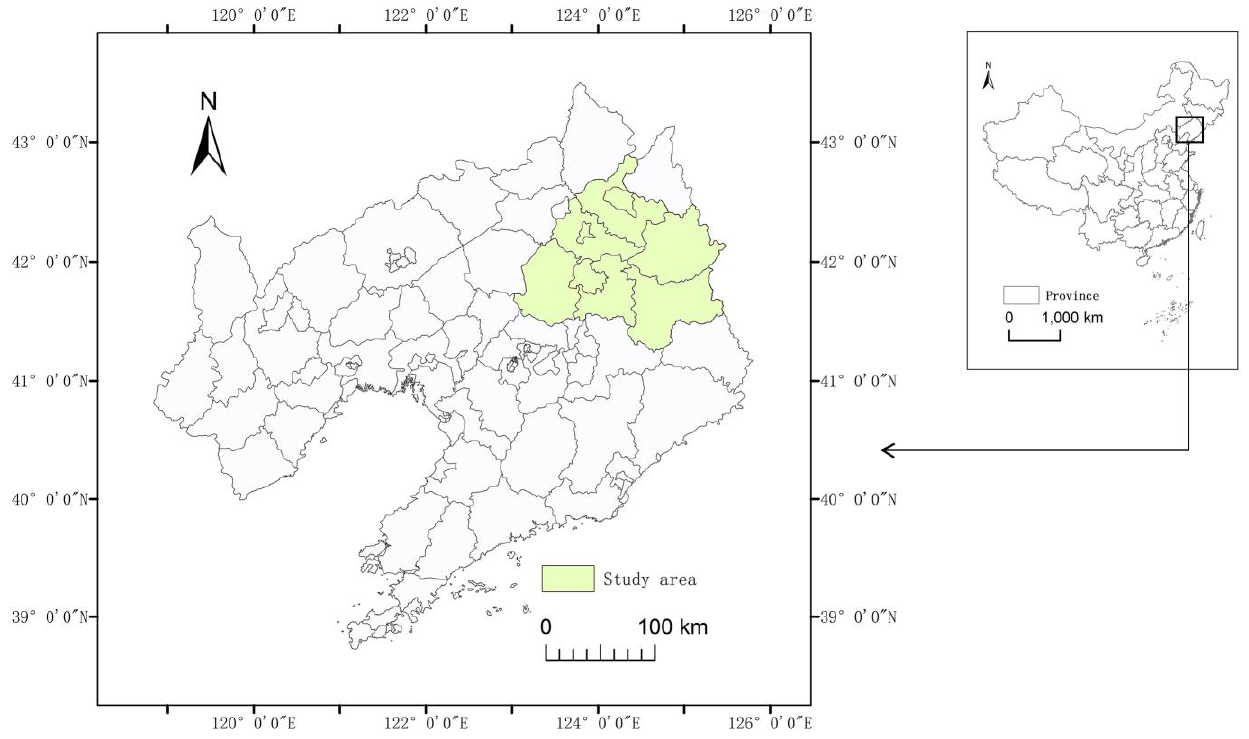
Figure 1. Liaoning Province, China.